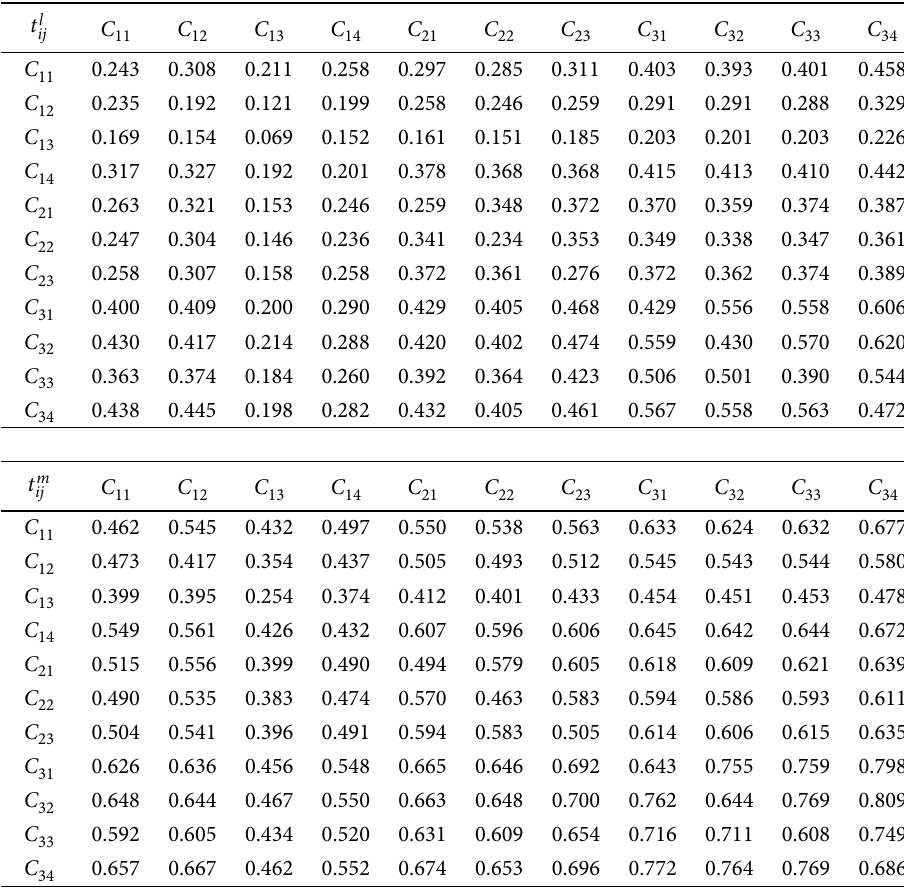
Table 3. The fuzzy total influence relation